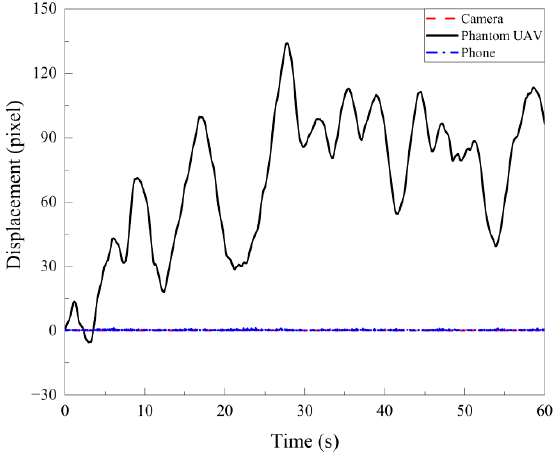
Figure 2. Comparison of lens drift time history from different equipment.